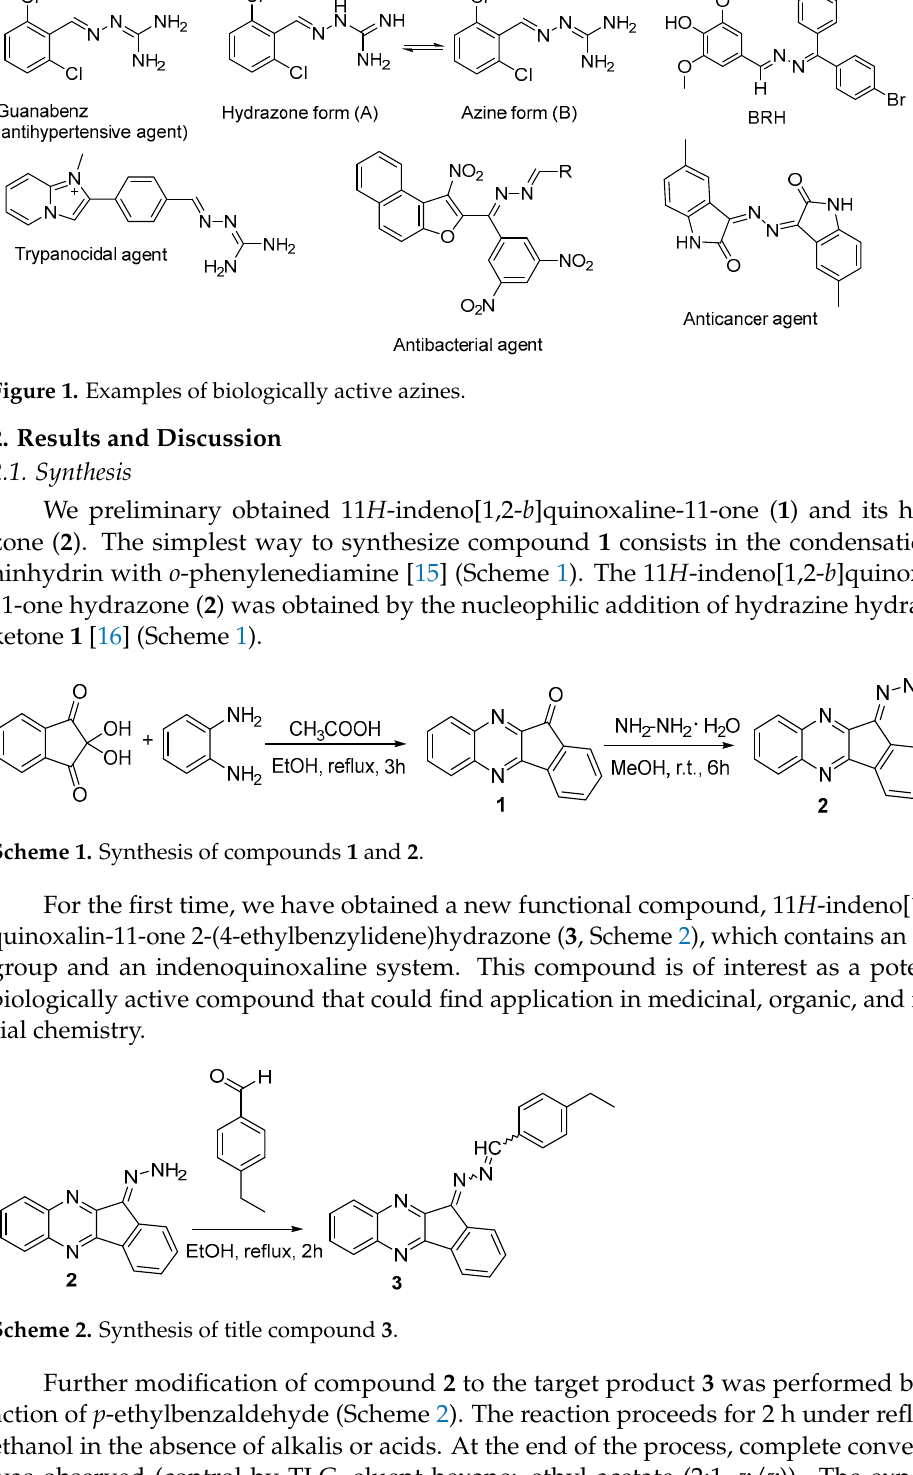
Figure 1. Examples of biologically active